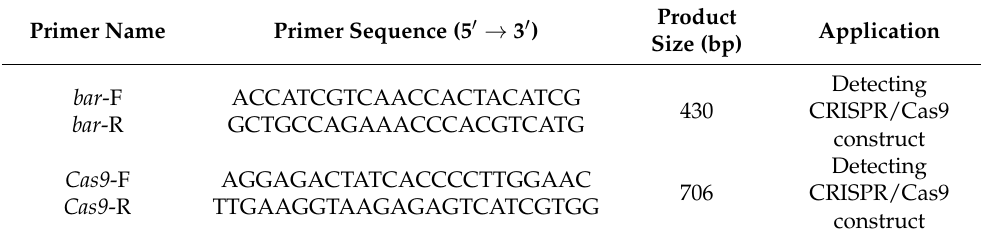
Table 1. The PCR primers used in this